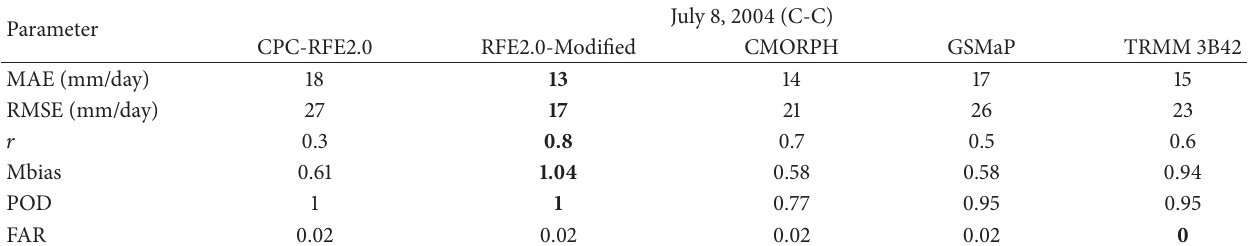
Figure 9: Seasonal error statistics of different satellite products for 2004 to 2006 (G-G analysis). Table 4: Daily catchment error statistics of satellite rainfall on July 8,